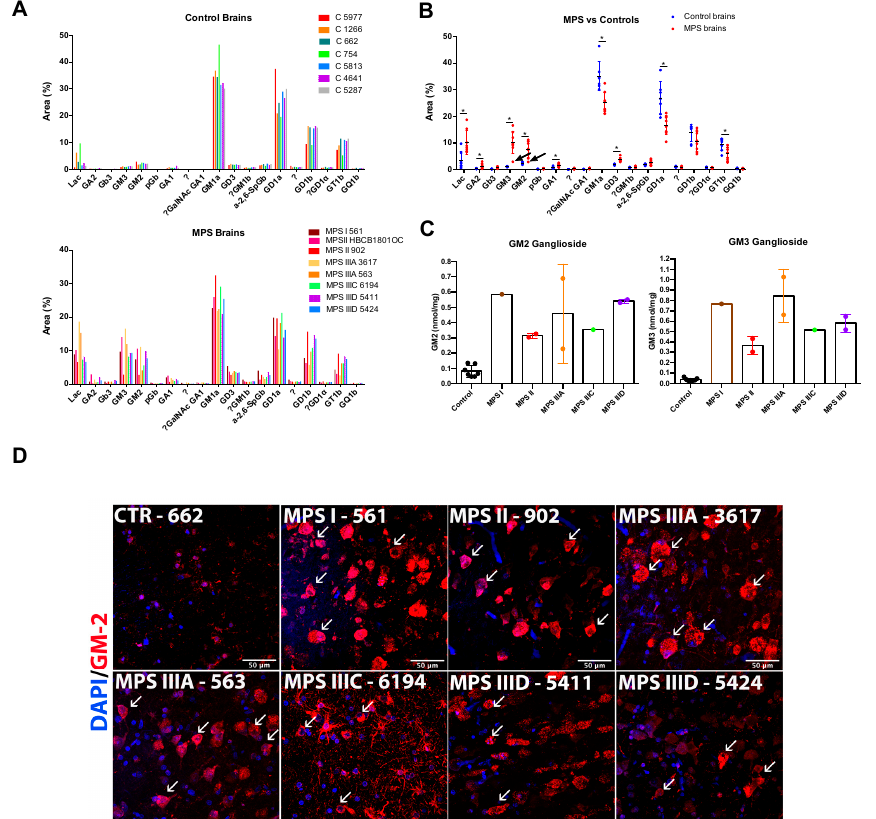
Figure 2. Sphingolipid levels in the brains of MPS patients and controls. Levels of glycans produced by enzymatic cleavage of total sphingolipid extracts of MPS patients and controls were measured by normal HPLC and plotted for the individual MPS patients and controls ( A ) or grouped for all patients and controls ( B ). The values show percentage of the specific lipid. The “?” means that the identity of the sphingolipid was unknown, or could not be confirmed. Statistical significance of changes was estimated using Mann–Whitney multiple comparison test (* p < 0.05). ( C ) Levels of simple GM2 and GM3 gangliosides grouped according to the type of MPS disorder. ( D ) Confocal microscopy images of brain cortex tissues of MPS I (561), MPS II (902), MPS IIIA (3617 and 563), MPS IIIC (6194), and MPS IIID (5411 and 5424) patients and a representative control (662) stained with antibodies against GM2 (red). The fixed brain tissues of the MPS II patient HBCB1801OC were not su ffi ciently preserved to perform cryosectioning and conduct immunofluorescent analysis. 4 (cid:48) ,6-Diamidino-2-phenylindole (DAPI, blue) was used as the nuclear counterstain. Neurons with GM2 storage are shown with arrowheads. Scale bar: 50 µ